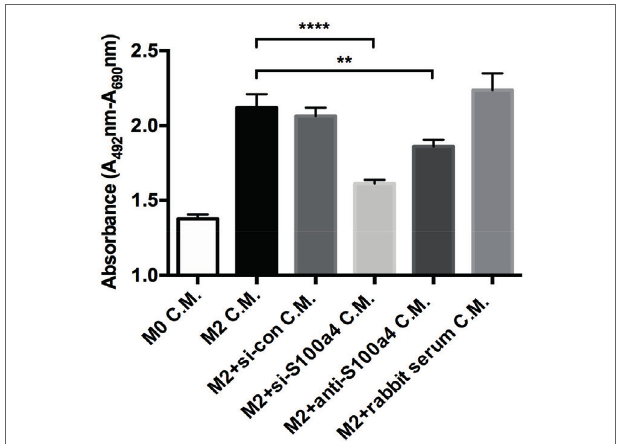
FigUre 6 | Effect of conditioned medium on lung fibroblast proliferation. Primary lung fibroblasts were treated with conditioned medium (C.M.) from M0, M2, and M2 macrophages transfected with scrambled or S100a4- specific siRNA. In addition, specific S100a4 antibody or isotype control rabbit serum pre-treated M2 conditioned medium were used to stimulate lung fibroblasts. Cell proliferation was analyzed by using XTT kit after 48 h of treatments. Results are representative of two independent experiments with similar results. Shown are mean ± SD of five replicates from one experiment. Unpaired t -test was performed for statistical analysis (** denotes p < 0.01; ****denotes p <